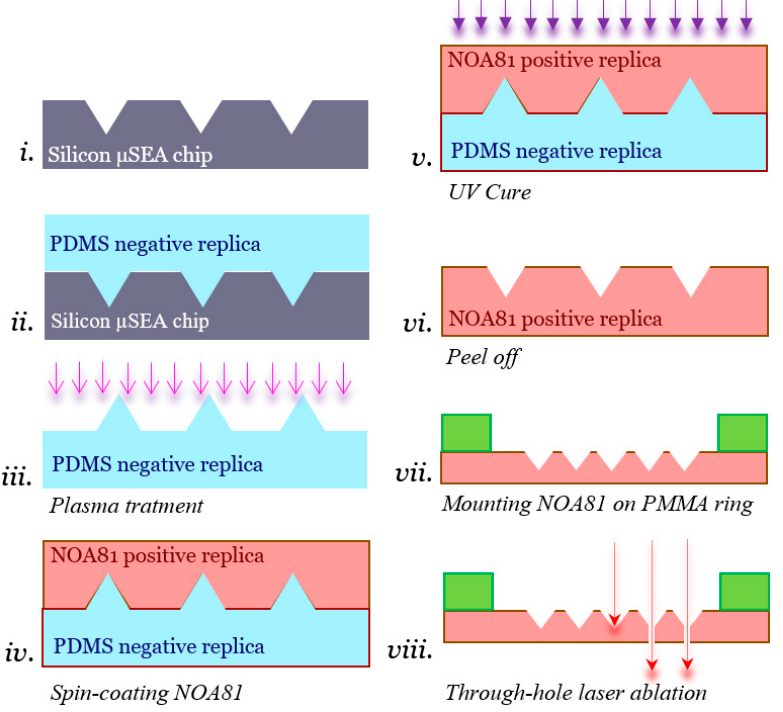
Figure 1. Replica molding and laser ablation process workflow for NOA81 microsieve. From a clean silicon electrode microsieve array (µSEA), ( i ) a negative replica is created by casting polydimethylsiloxane (PDMS) (10:1 w / w ratio) followed by curing at 95 ◦ C and peeling off ( ii ). The PDMS mold is then oxygen-plasma-treated with 10 W for 30 s to become hydrophilic and allowing for a wetting of NOA81 during spinning ( iii ). An excess of NOA81 is poured onto the mold and spin-coated at 500 rpm for 30 s followed by whatever speed results in the final thickness for 60 s ( iv ). The NOA81 is then cured under ultraviolet (UV) light with an energy amount of 2100 mJ/cm 2 at an intensity of 15 mW/cm 2 ( v ). NOA81 is then peeled off quickly ( vi ) and is mounted on a polymethyl methacrylate (PMMA) ring ( vii ). The assembly is then submitted to an excimer laser station to produce the through-holes in the pyramid structures by ablation ( viii ).